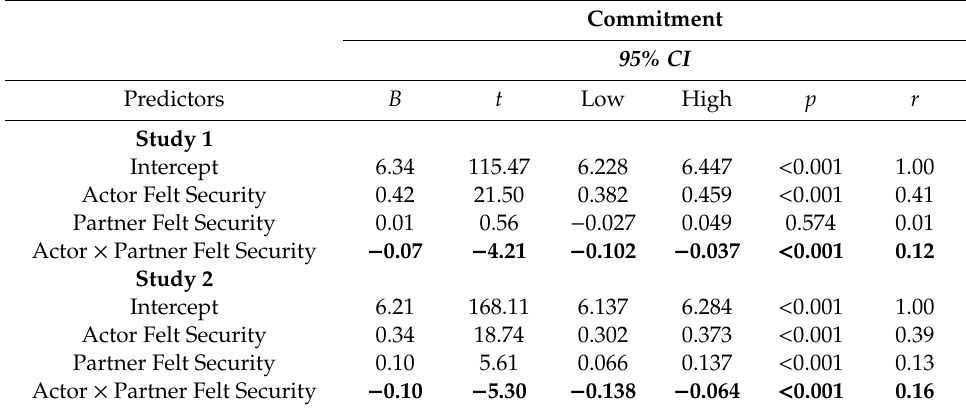
Table 2. The e ff ects of actor and partner daily felt security on actors’ daily commitment.